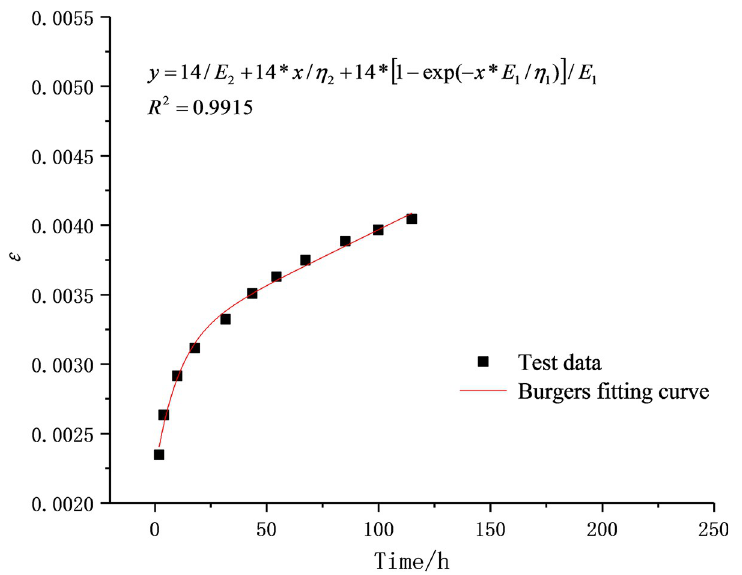
Fig 9. Fitting curve in stable creep stage.